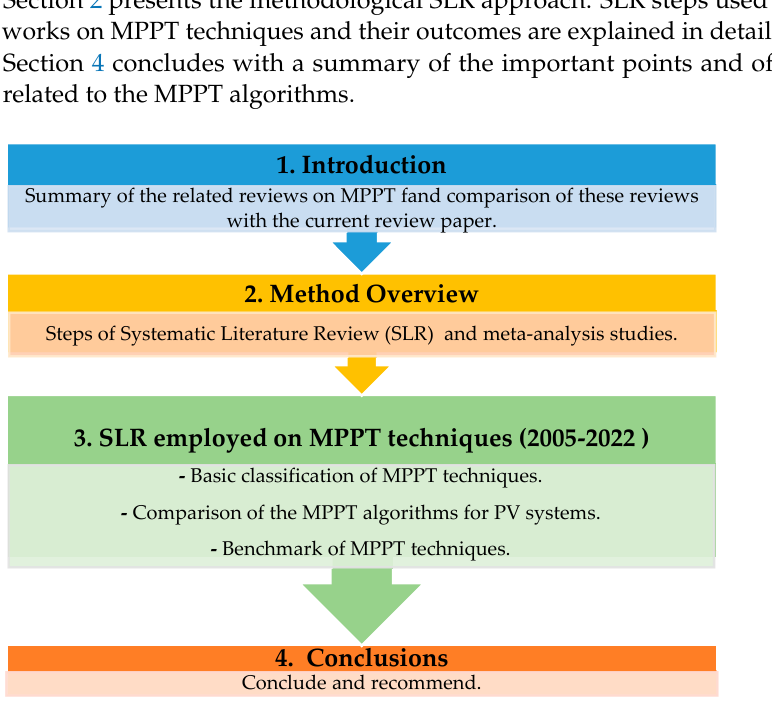
Figure 1. Diagrammatic view of the organization of the